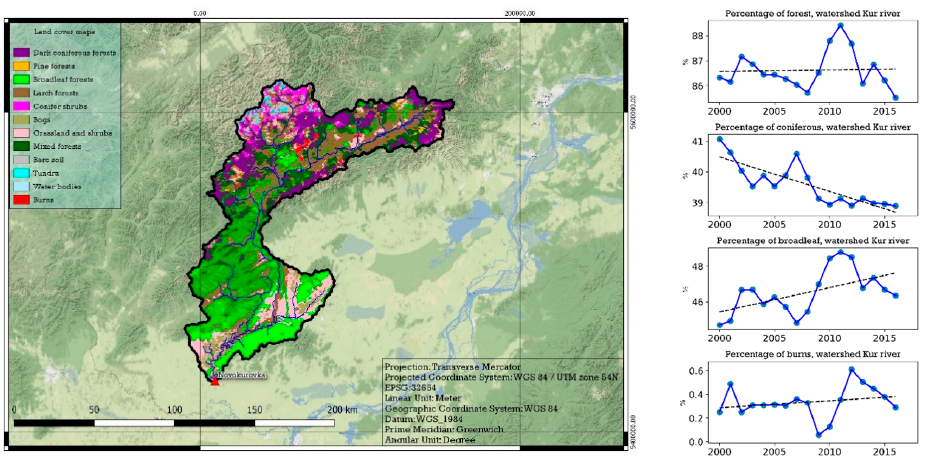
Figure 13. Vegetation dynamics of Kur River watershed. Stream gaging is marked with the white diamond.